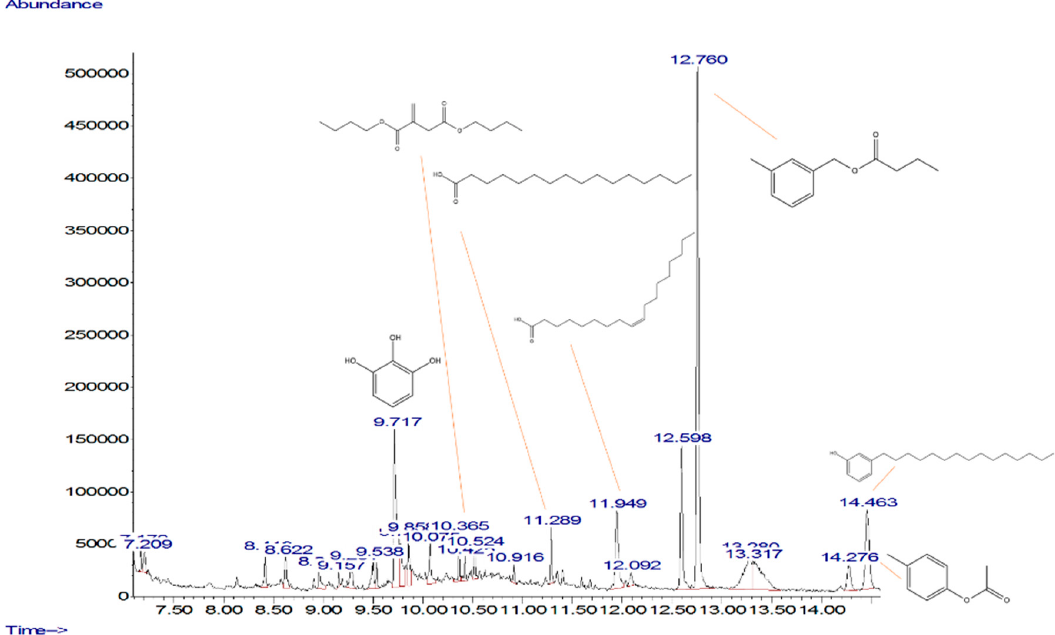
Figure A1. GC-MS chromatogram obtained from MEW–pistachio hull. Appl. Sci. 2019 , 9 , x FOR PEER REVIEW